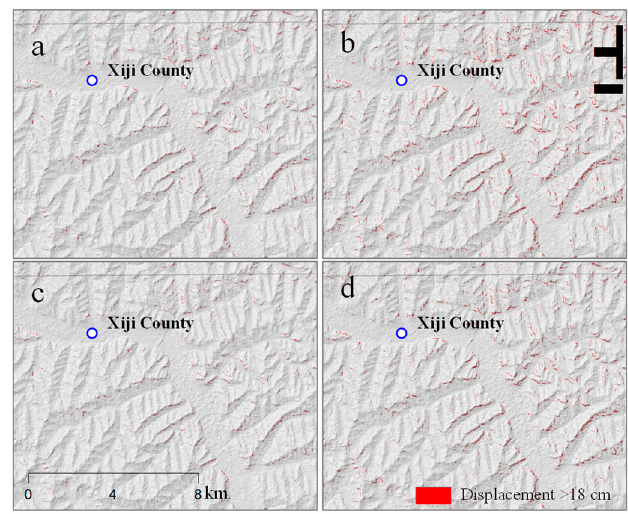
Figure 6. The slope failure distribution with a displacement above 18 cm; ( a ) seismic magnitude of Ms 7.5 along the Haiyuan Fault, ( b ) seismic magnitude of Ms 8.5 along the Haiyuan Fault, ( c ) seismic magnitude of Ms 7.5 along the Liupanshan Fault, and ( d ) seismic magnitude of Ms 8.5 along the Liupanshan fault.